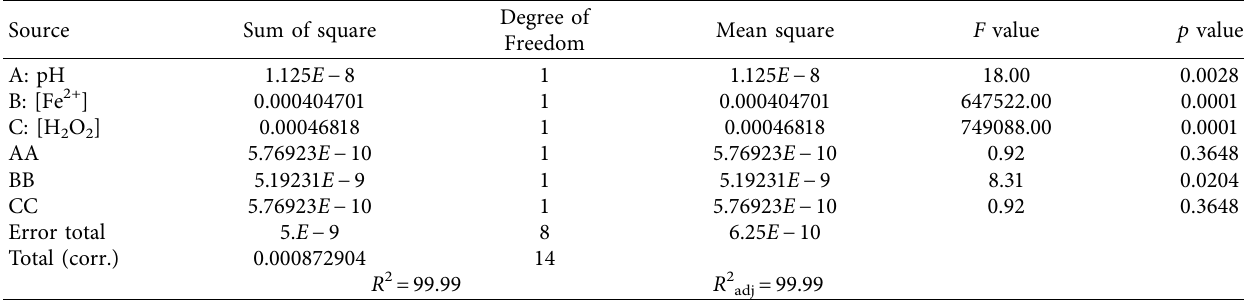
Table 4: Analysis of variance for the COpT polynomial model (USD/m 3